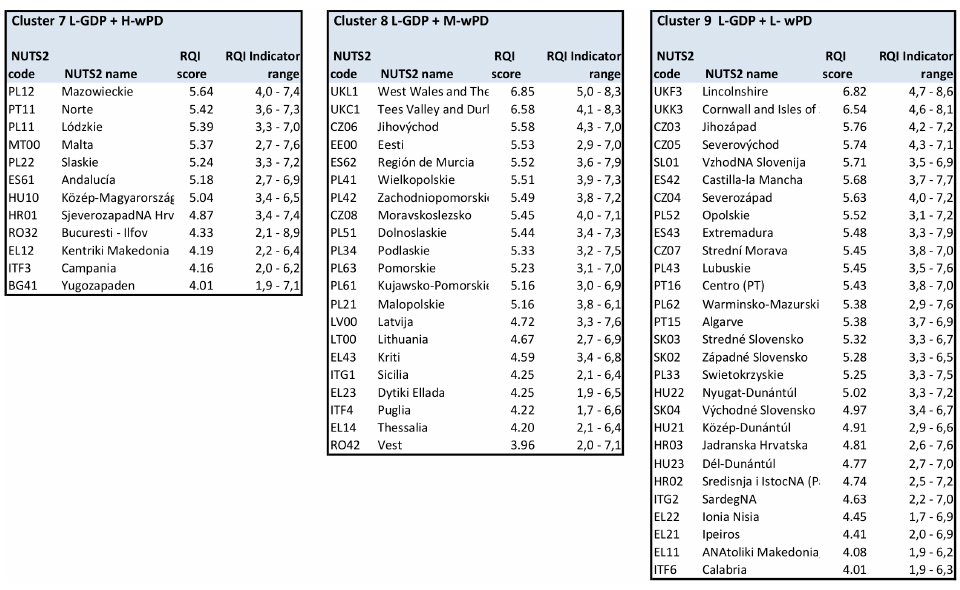
Table A.4: Regions with Low